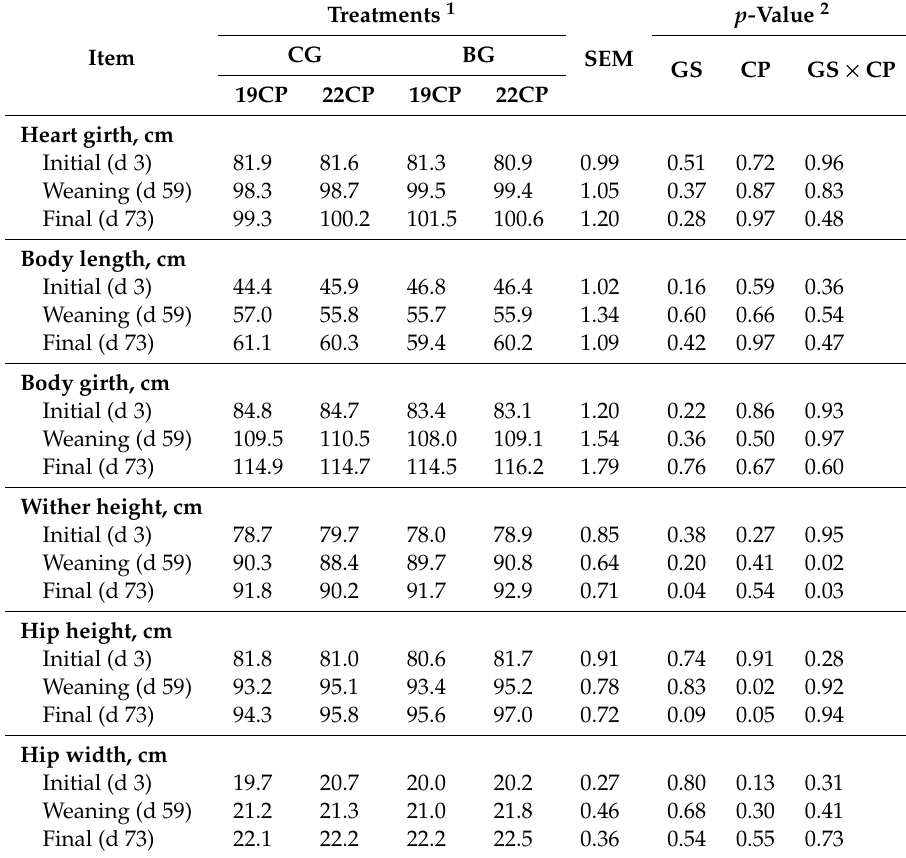
Table 3. Least square means for growth parameters in dairy calves fed di ff erent grain sources (corn grain vs. barley grain) and di ff erent protein levels (19% vs. 22 % of DM) ( n = 10 calves per